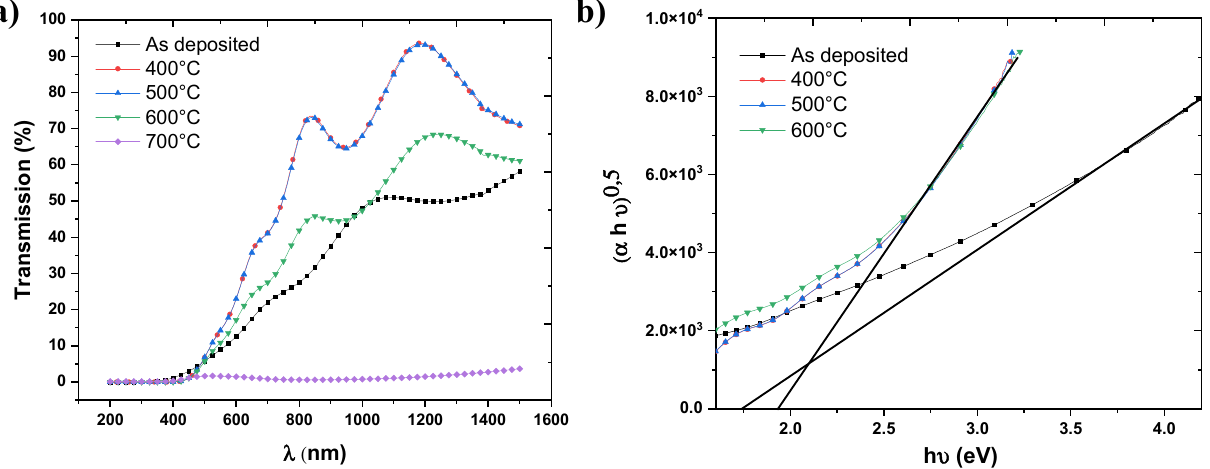
Figure 3. ( a ) Transmission spectra of the LMO film as deposited and after annealing (400 °C, 500 °C, 600 °C and 700 °C). ( b ) Determination of the optical gap.